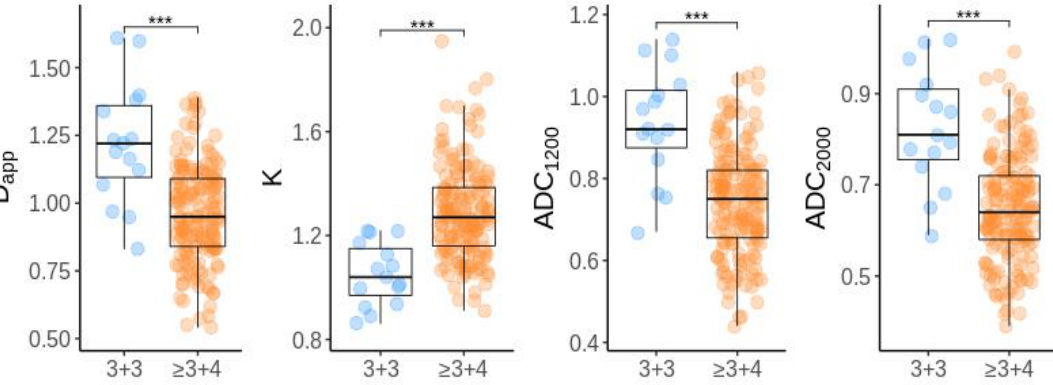
Mean D app , K, ADC 1200 , and ADC 2000 values were significantly different between low- and higher-grade tumors ( p < 0.001). In both DKI and ADC parameters, an overlap of values was observed between the low-(GS ≤ 3 + 3) and higher-grade (GS ≥ 3 + 4) tumors (Figure 4). (Figure 4).